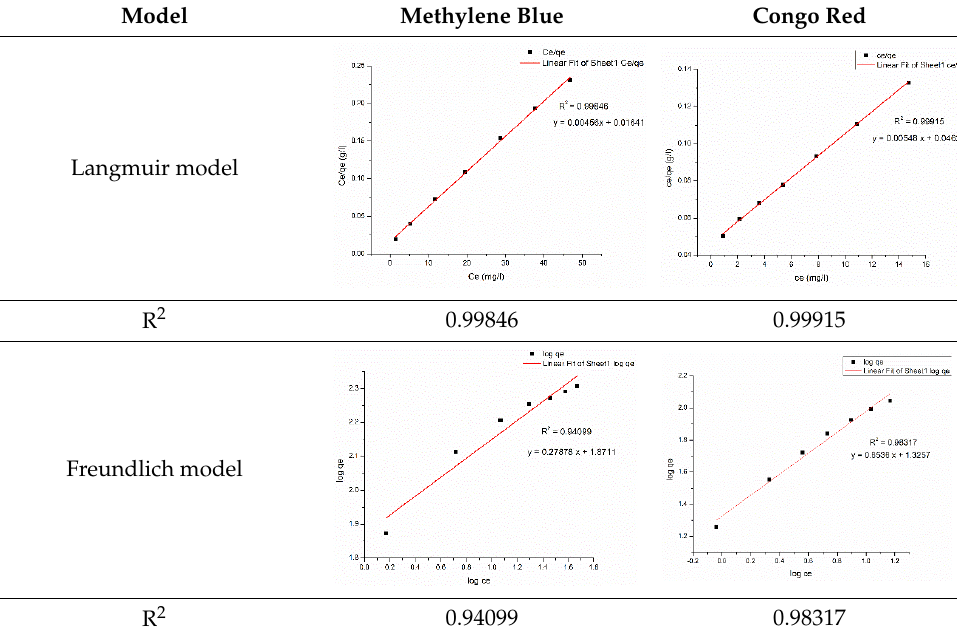
Table 3. Adsorption isotherm graphs of Langmuir and Freundlich isotherm models for the dyes MB and CR at temperature = 300 K, pH = 7, adsorbent dosage = 5 mg, and contact time = 48 h.